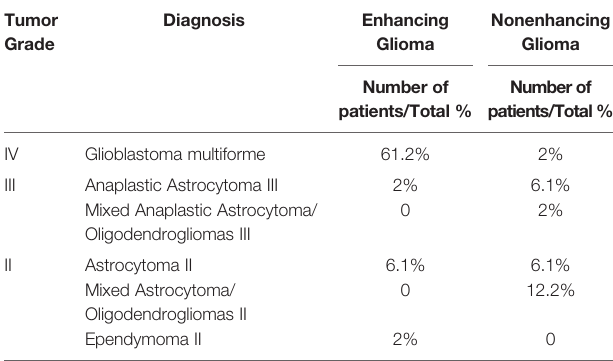
TABLE 1 | Summary of clinical description of patients in TCIA